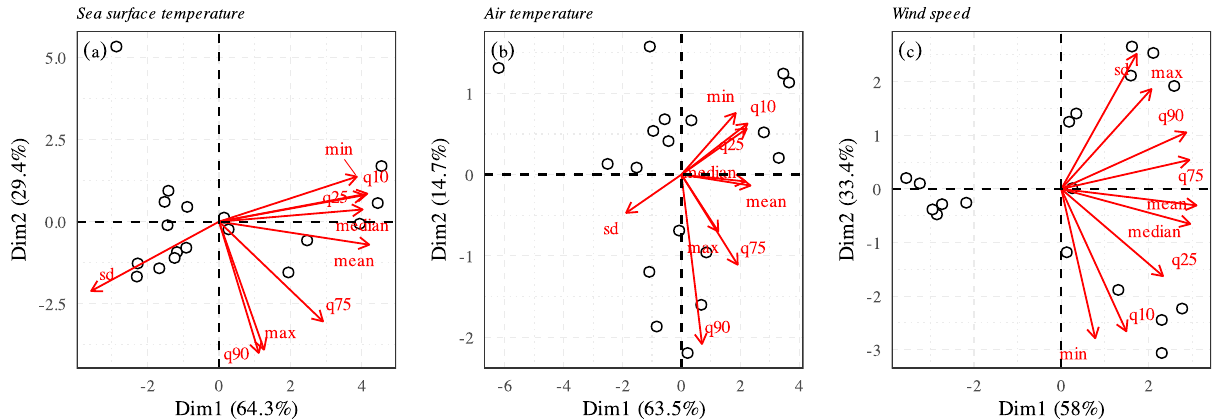
Fig. 5 Biplot of environmental principal component analyses. Biplots of sea surface temperature, air temperature, and wind speed regimes for the Belgian coast from 1890 until 2019 showing the loading of each variable (red arrows) and the PCA scores of each sampling year (points). Arrow directions indicate direction of increasing values of the respective variable and placement of the sampling year indicate how each year is related to the principal components. a Biplot of principal component analyses of descriptive statistics for sea surface temperature covering 93.7% of the total variability. b PCA biplot of air temperature covering 78.2% of the total variability and c PCA biplot of wind speed covering 91.4% of the total